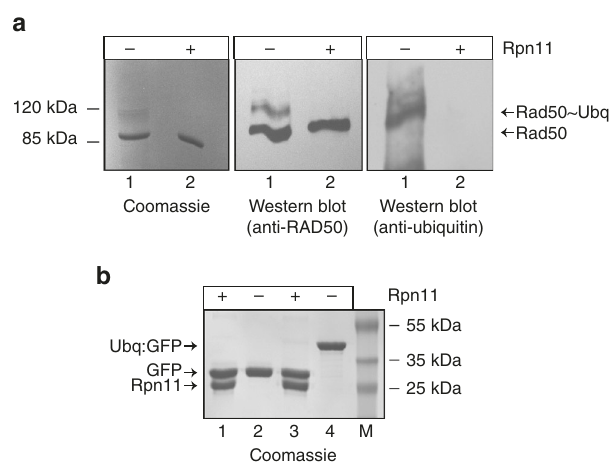
Fig. 8 The Rpn11 JAMM metalloprotease acts as a deubiquitinase (DUB) to deconjugate isopeptide-linked ubiquitin moieties. a (left) Coomassie stained gel of the ubiquitylated S. solfataricus Rad50 product incubated either with (lane 1) or without (lane 2) Rpn11 treatment. Middle and right; western blot of duplicate gels, probed with an anti-Rad50, or anti-ubiquitin antibodies, respectively. b The Rpn11 homologue also cleaves ubiquitin moieties linked to the N-terminus of a substrate. Superfolder (sf)GFP or a 1xUbiquitin fusion to the N-terminus of sfGFP (1xUbq:sfGFP) incubated in the presence or absence of Rpn11. Lane 1: (sf)GFP plus Rpn11. Lane 2: sfGFP alone. Lane 3: 1xUbq:GFP following incubation with the Rpn11 protein.